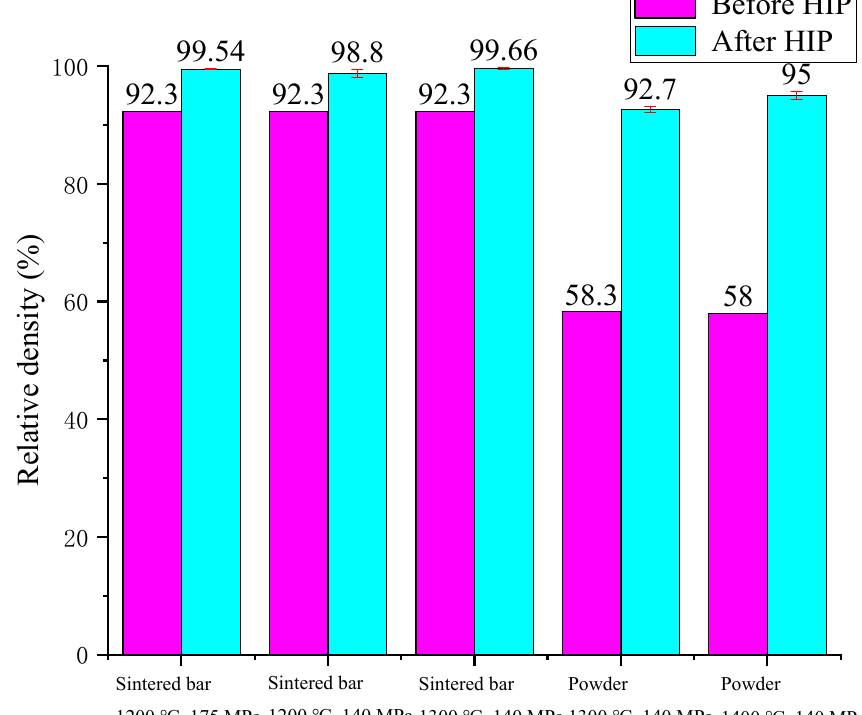
Figure 5. The relative density of tungsten alloy before and after HIP.